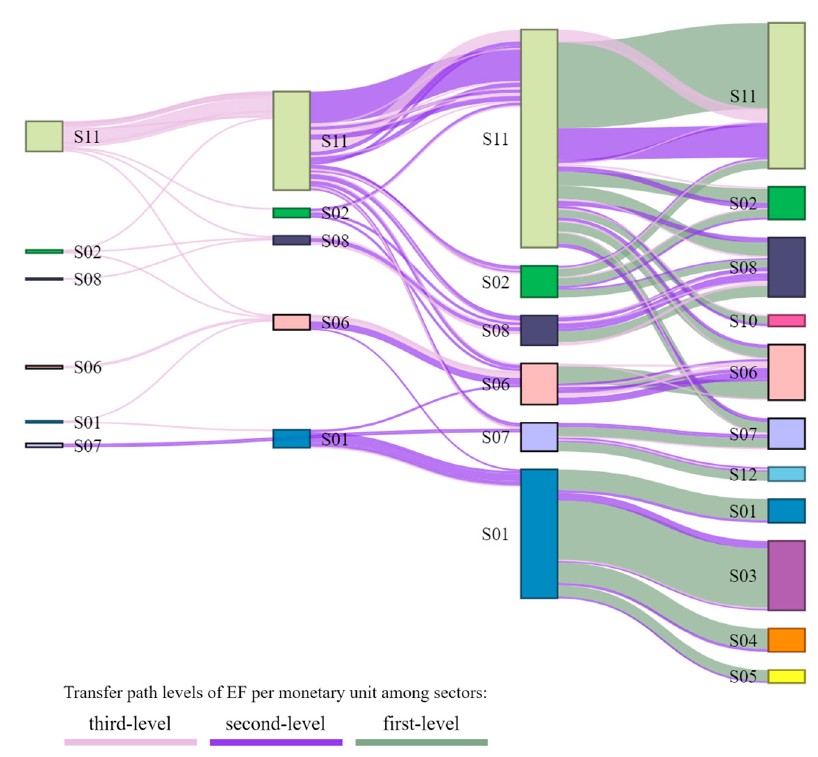
Figure 8. The key transfer path of China’s EF per monetary unit among sectors in 2015.